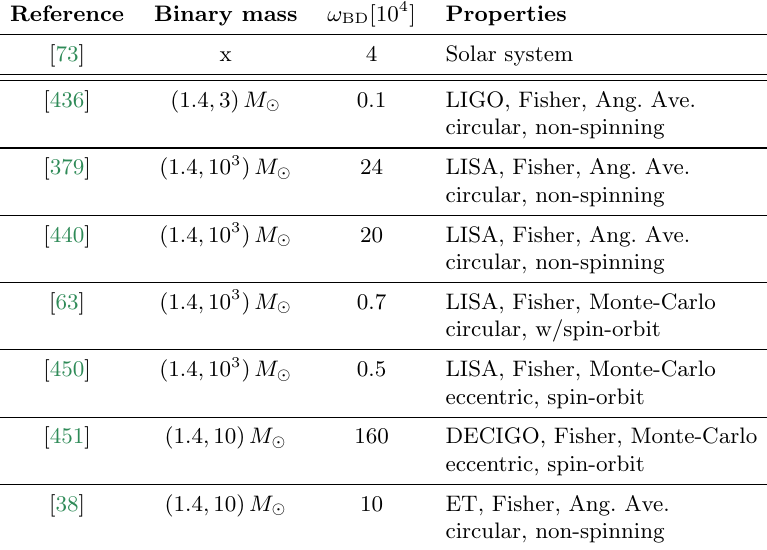
Table 1: Comparison of proposed tests of scalar-tensor theories. Reference Binary